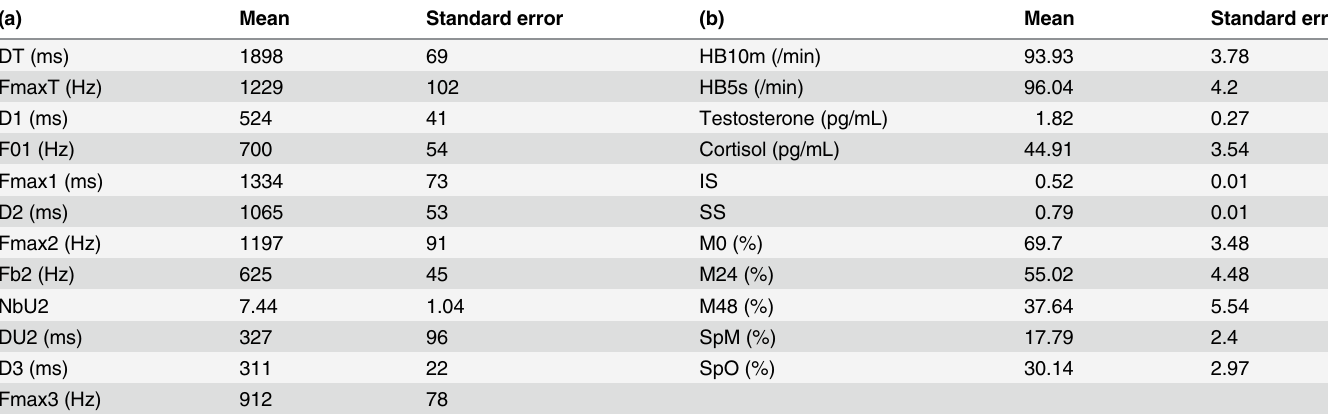
Table 2. Acoustic (a) and physiological (b) traits of stallions (mean ± SE) (N = 15 stallions).